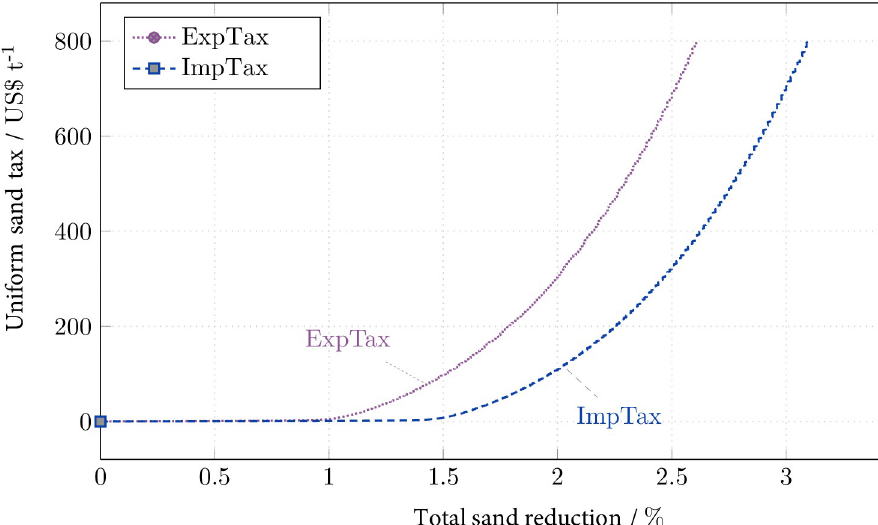
Fig 2. Tax rate (marginal reduction cost) as a function of the total reduction of sand extraction under the export/ import tax (ExpTax/ImpTax).